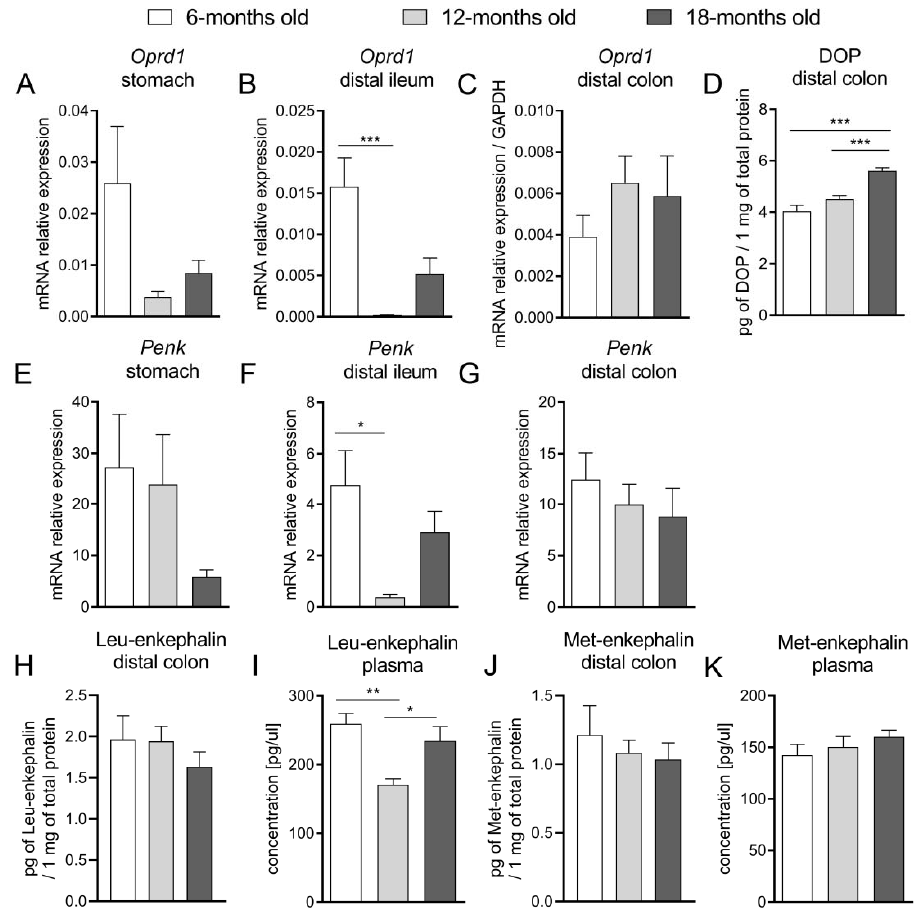
Figure 4. The mRNA expression of the Oprd1 gene, encoding DOP receptor, in the stomach ( A ), distal ileum ( B ) and distal colon ( C ). The protein expression of DOP receptor ( D ) in the distal colon. The mRNA expression of Penk in the stomach ( D ), distal ileum ( E ) and distal colon ( F ). The protein expression of endogenous enkephalins: Leu-enkephalins ( H , I ) and Met-enkephalins ( J , K ) in the distal colon and in the plasma of 6-, 12- and 18-months old mice. Differences between groups were tested with one-way ANOVA followed by Bonferroni corrections for multiple comparisons apart from block ( A ) where Welch ANOVA test followed by Tamahane’s T2 was used, block ( C , G ) where Kruskal–Wallis test was applied with post hoc Dunn’s multiple comparisons test. * p < 0.05, ** p < 0.01, *** p < 0.001.